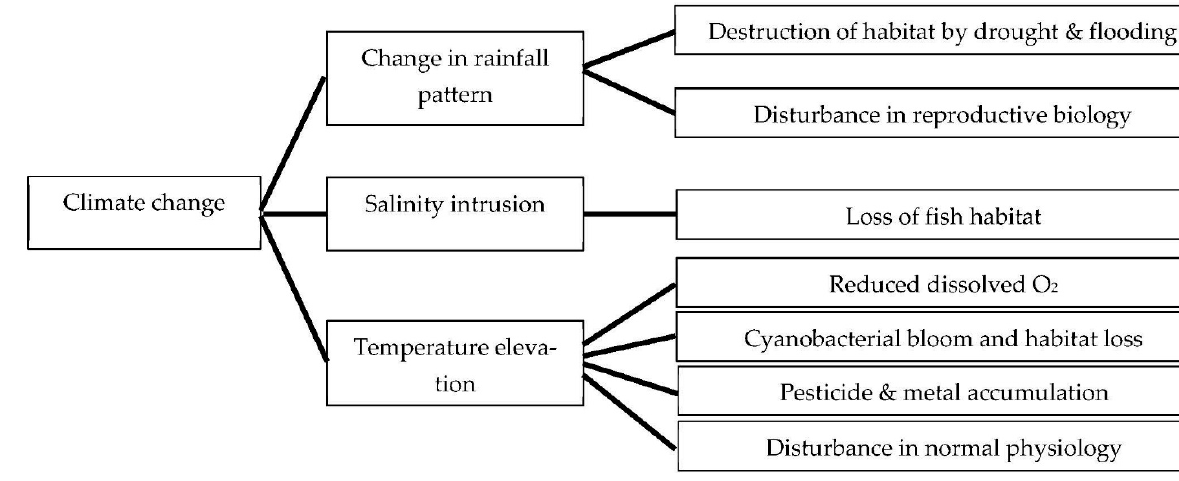
Figure 4. Effects of climate change on B. bagarius.